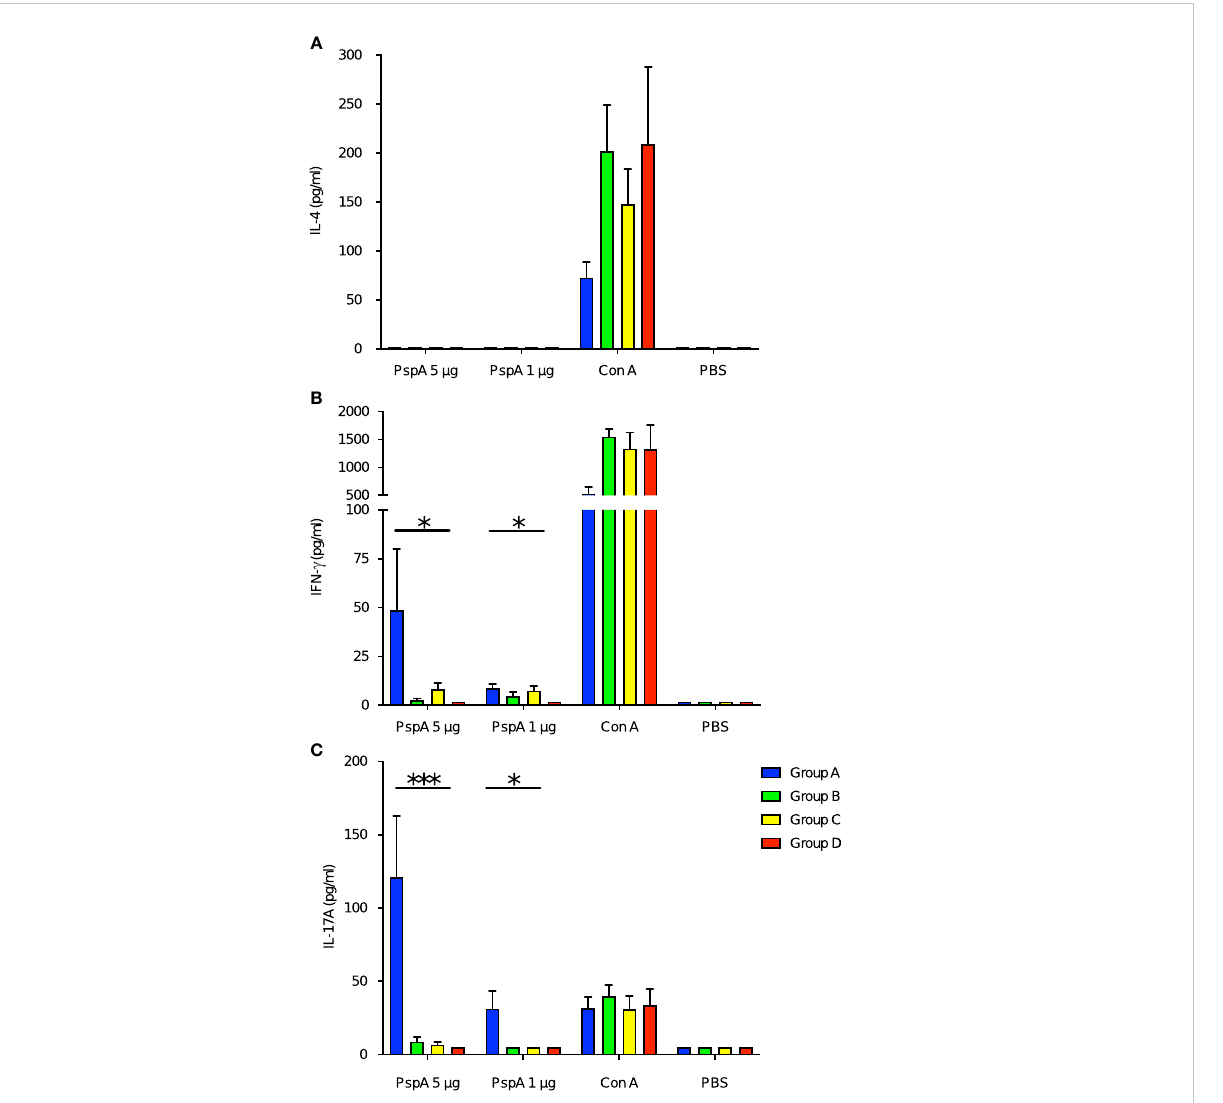
FIGURE 5 Cytokine production from splenocytes of offspring by PspA stimulation. At the age of week-old, the splenocytes from offspring were incubated with rPspA (1 or 5 µg) or concanavalin A for positive control. Cytokines in the supernatant were quanti fi ed by ELISA. (A) IL-4, (B) IFN- g , (C) IL-17A. Data is shown as mean with standard error. Blue bar, green bar, yellow bar, and red bar represent Group A (n=6), Group B (n=6), Group C (n=6), and Group D (n=6) respectively. Kruskal-Wallis test with Dunn ’ s multiple comparison was performed for comparison was performed for comparison between the groups. *; P <0.05, ***; P